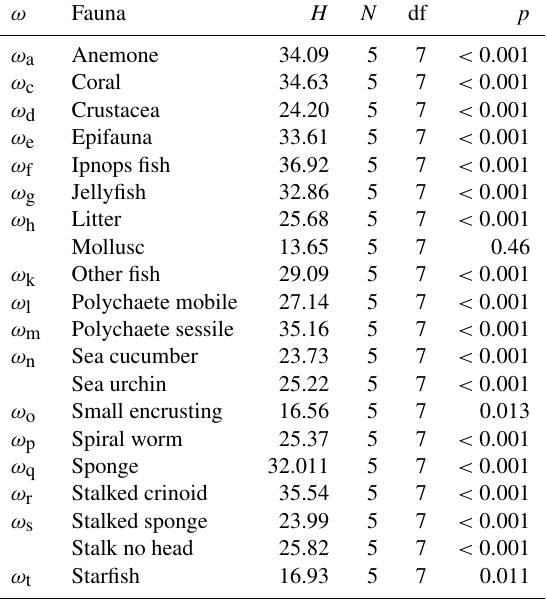
Table 3. Kruskal–Wallis test assessment of whether differences in fauna abundance derived from the DISCOL seafloor data are signif- icant for each fauna category used in the current study. H is the test statistic, N is the number of observers, df is degrees of freedom (i.e. number of data types compared − 1) and p is significance. P values of less than 0.05 indicate significance at the 95% percentile.